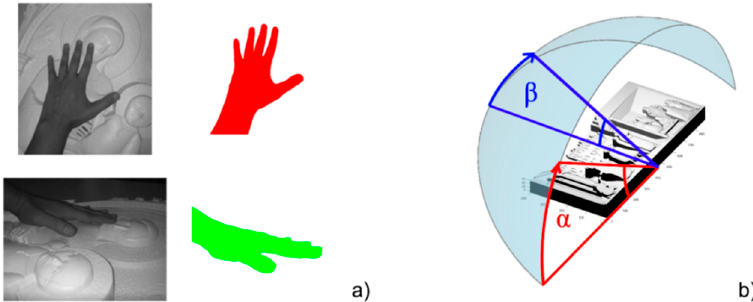
Figure 9. ( a ) Views and silhouettes of the user hand as seen by the Kinect ® with different elevation angles; ( b ) Bas-relief reference frame for Kinect ® positioning, where α is the azimuth angle and β the elevation angle.